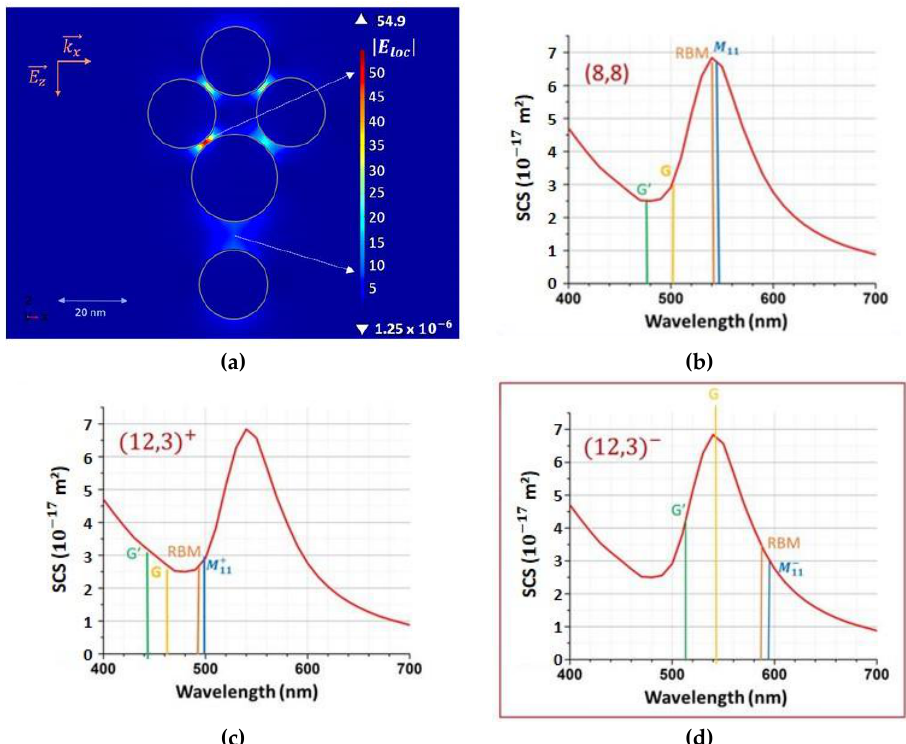
Figure 8. FEM computations coupled with metallic CNT behaviors. ( a ) the FEM simulations of the electric field show (indicated with the white arrows) two strong enhanced field area. The CNT 1 is in the region where the field is enhanced by 10. The different possibilities to generate Raman resonance effects (at the excitation, transition M 11 in blue or at the scattered resonances for the three principal Raman CNT signals). ( b ) If CNT 1 was a (8,8) SWCNT the resonance at 561 nm would enhance the excitation Raman process, in this case, all the spectrum would be enhanced. ( c ) For the first electronic transition of a (12,3) SWCNT, neither the transition at the excitation and no inelastic scatterings could be enhanced by the resonance of the plasmonic molecule. ( d ) For the second transition of a (12,3) SWCNT, the Raman resonance at the excitation is weakly enhanced, while the Raman resonance at the scattering would favor the G-signal. This latter case allows interpreting the signals observed in Figure 5.